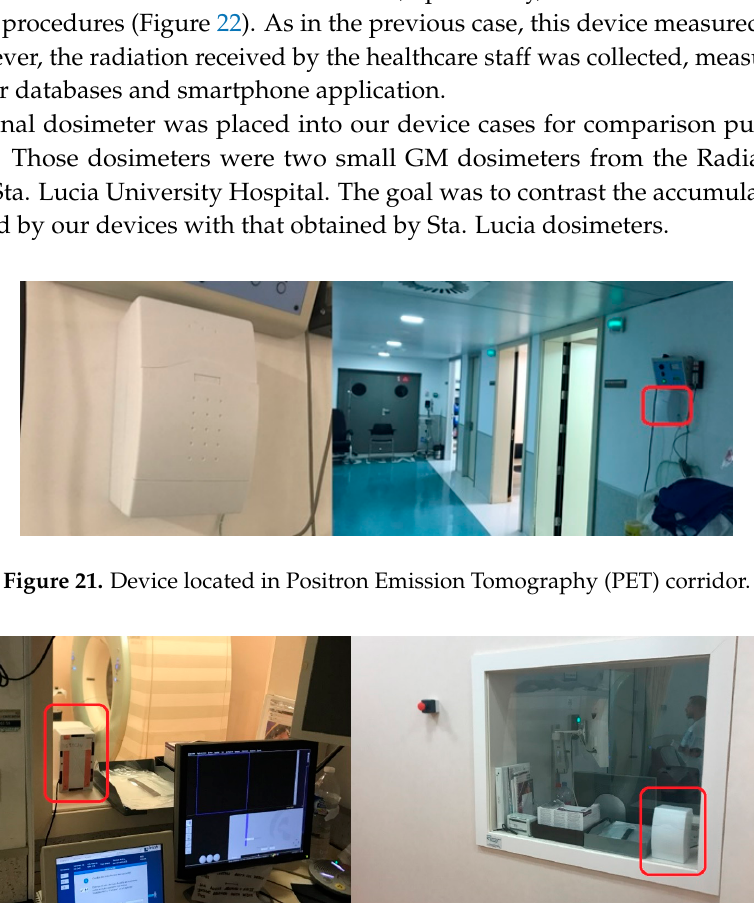
Figure 23. PET corridor results. Figure 24. Results in room next to CT room.